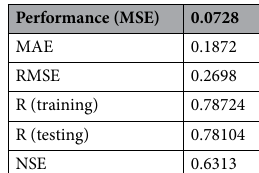
Table 10. Evaluation using BR